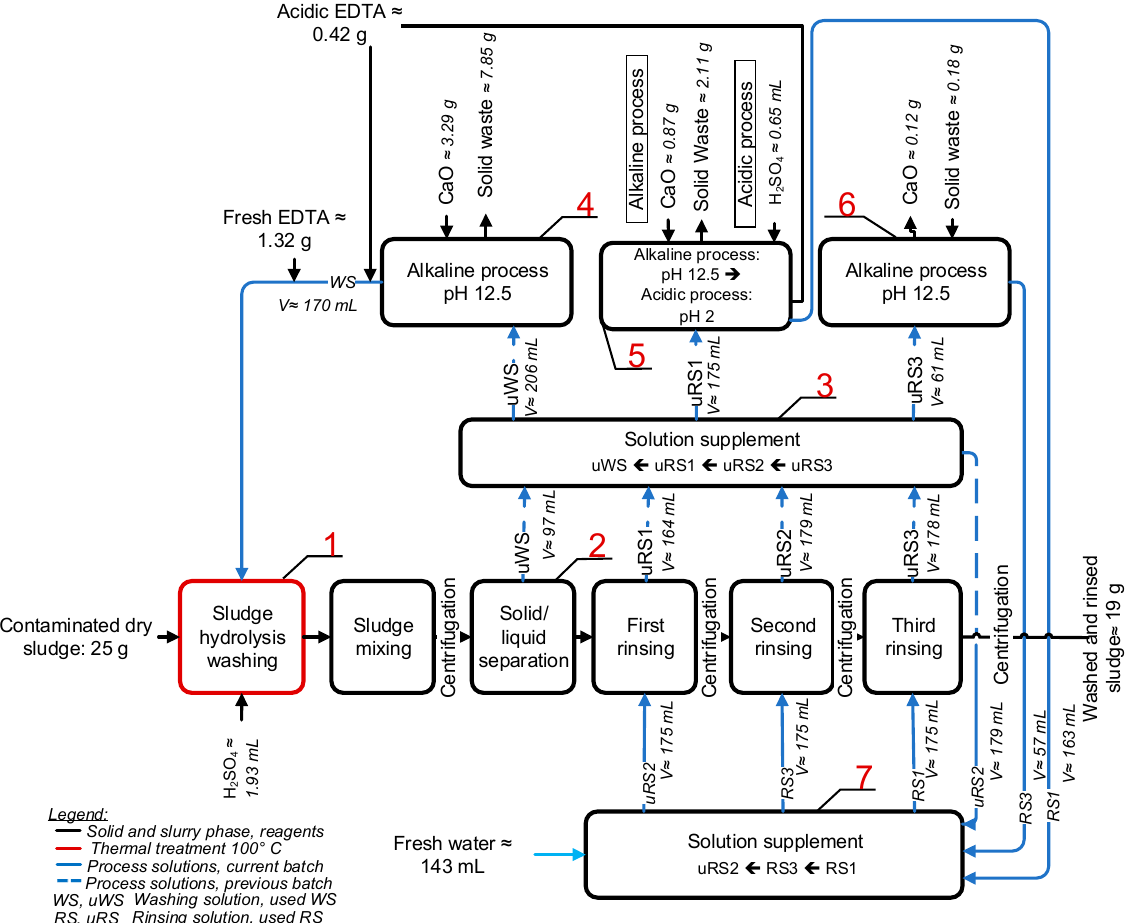
Figure 1. The flowchart of the process with material balance. Process steps: (1) sewage sludge (SS) microwave-assisted acid hydrolysis and EDTA washing, (2) solid/liquid separation and SS rinsing, (3) compensation of water losses, (4) alkalization of uWS, (5) alkalization/acidification of uRS1, (6) alkalization of uRS3, and, finally, (7) the upstream supplement of process solutions with fresh water to reach the final volume. WS, uWS denotes washing and the used washing solution, RS1 and uRS1 represent first rinsing and the used rinsing solution, RS2 and uRS2 represent second rinsing and the used rinsing solution, RS3 and uRS3 represent third rinsing and the used rinsing solution. Blue lines denote the flow of solutions, dashed blue lines denote the flow of solutions from the previous batch, black lines denote the flow of